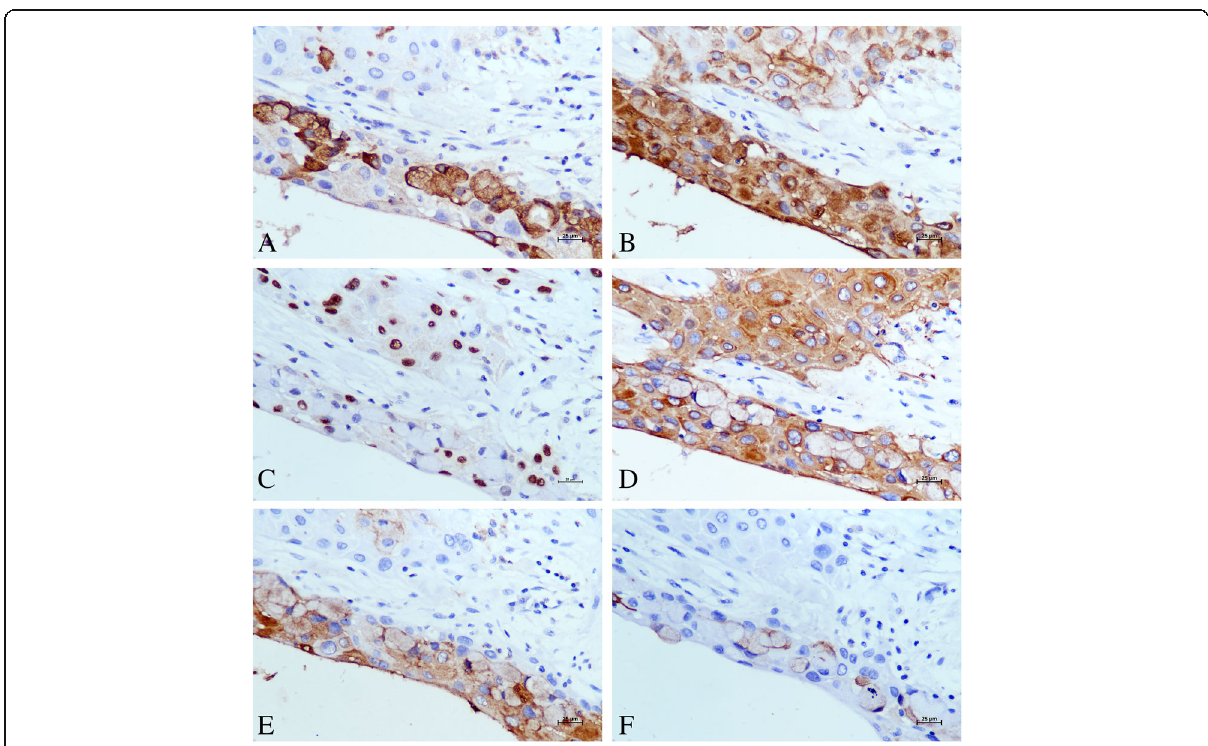
Fig. 3 Immunohistochemical results. a Immunopositivity for cytoplasmic MUC5AC was detected in malignant mucinous cells, with negative staining in malignant epidermoid cells (magnification 400×). b Immunopositivity for membrane MUC1 was detected in all malignant epidermoid cells and mucinous cells (magnification 400×). c Immunopositivity for p63 was only detected in the nuclei of malignant epidermoid cells (magnification 400×). d Cytoplasmic CK19 staining was diffusely positive in the malignant epidermoid and mucous component of the tumor (magnification 400×). e Cytoplasmic CK7 staining was focally positive in the malignant epidermoid and mucous component of the tumor (magnification 400×). f Mucous component of the tumor was focally positive for membrane CEA staining (magnification